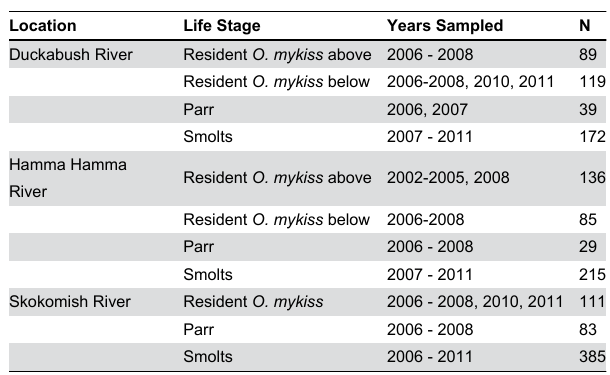
Table 1. The location, life stage (and for resident O. mykiss , if the fish was collected above or below a barrier to upstream migration), years sampled, and number genotyped of O. mykiss